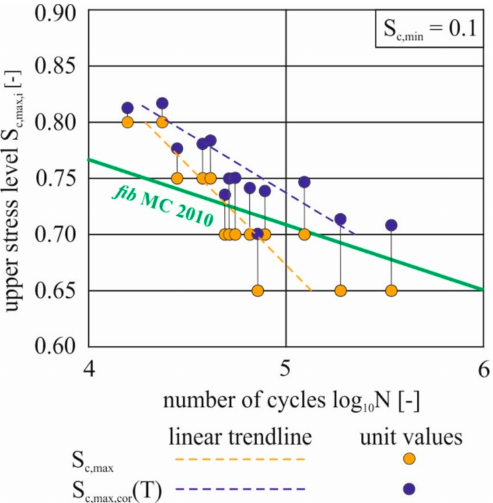
Figure 7. Achieved numbers of load cycles in relation to the planned upper stress levels S c,max as well as to the temperature-corrected upper stress levels S c,max,cor ( T ) according to Equations (4) and (5) with associated linear trend lines; f = 10 Hz and S c,min = 0.1.